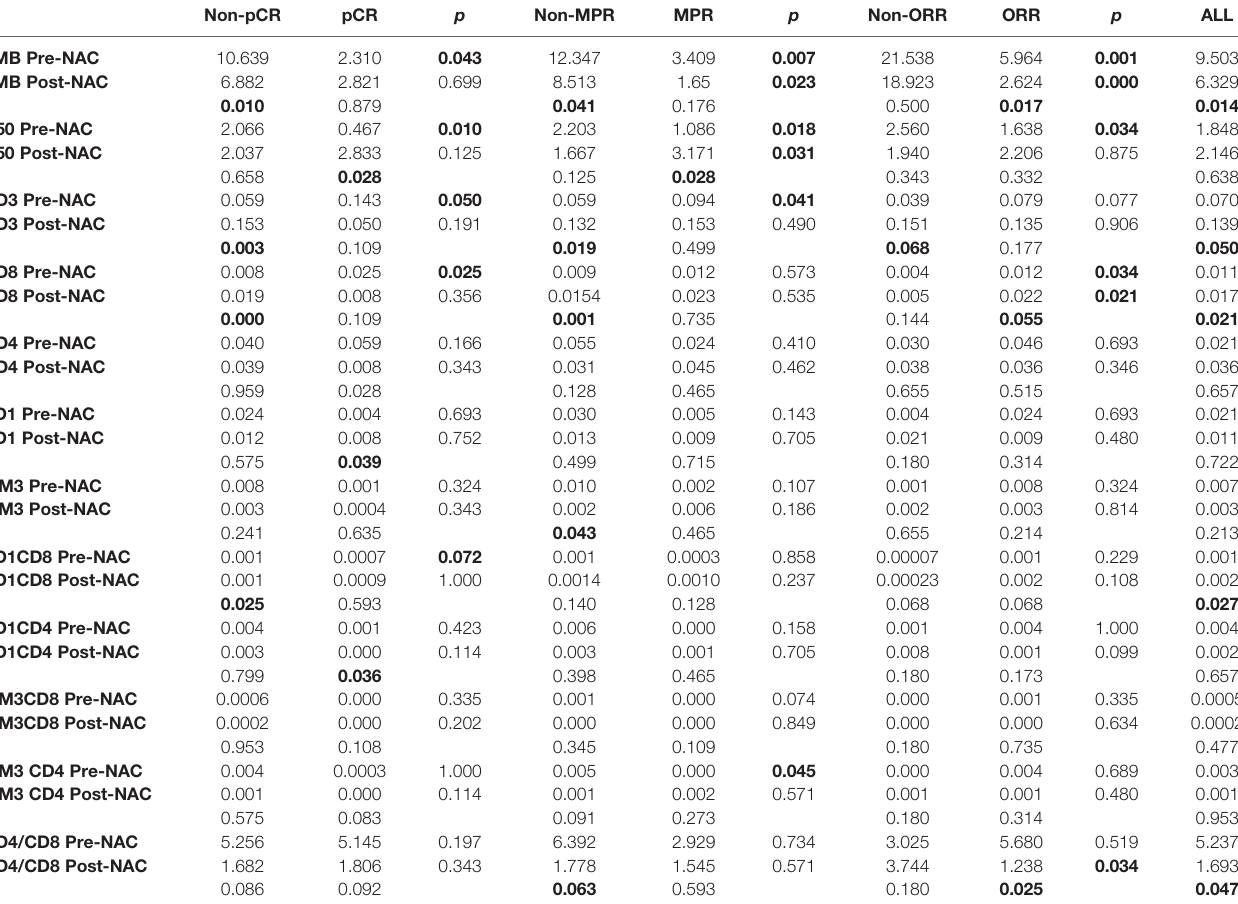
TABLE 2 | Comparison of TMB, D50, and immune factors pre-NAC and post-NAC in general population or patients with different curative effects. Non-pCR pCR p Non-MPR MPR p Non-ORR ORR p ALL TMB